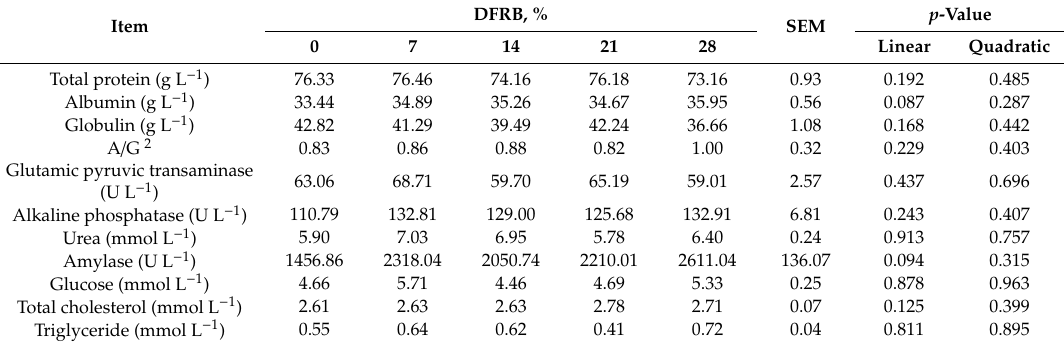
Table 4. E ff ects of increasing DFRB supplementation on serum biochemistry parameters of finishing pigs 1 .